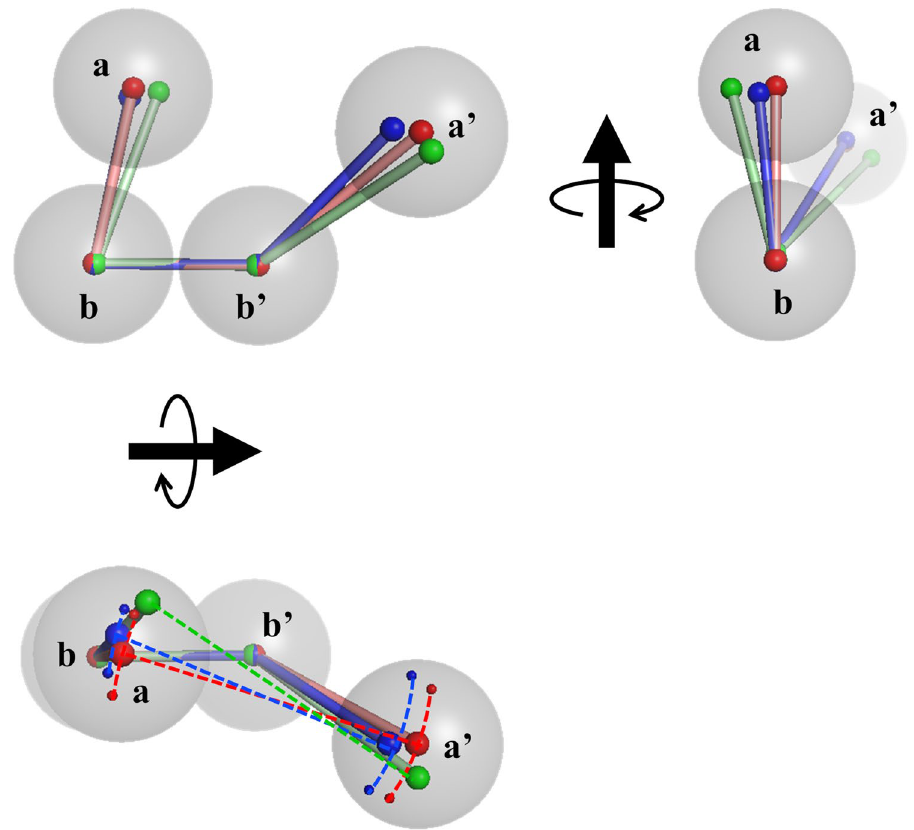
Figure 7. Comparison of the ball-and-stick models for ox- and red-models with that for the crystal structure. The averaged position of each domain is shown with red ball-and-stick models and with blue ball-and-stick models for ox- and red-models, respectively. The ox- and red-models and the crystal structure are aligned by the b and b ′ domains. The corresponding positions of the crystal structure are shown in the green ball-and-stick model. Gray balls roughly indicate domains as an eye guide. Dashed lines between smaller balls indicate the ranges of flexibility in the a and a ′